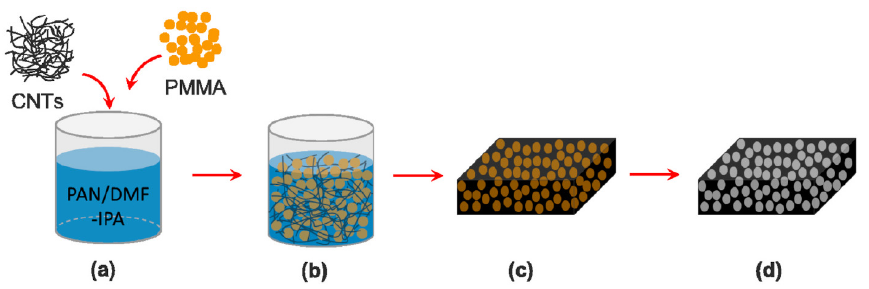
Figure 8. Schematic illustration of the fabrication process for preparing NC foam using the template method and PMMA microspheres. ( a ) The CNTs were dispersed in Polyacrylonitrile (PAN)/Dimethylformamide (DMF)- Isopropyl alcohol (IPA) solution and then Poly methyl methacrylate (PMMA) microspheres were added in. ( b ) The well-dispersed CNT and PMMA microspheres in PAN/DMF-IPA solution after sonication. ( c ) The mixture of CNTs/PAN/PMMA microspheres after filtration. ( d ) The NC foam after thermal treatments [95].